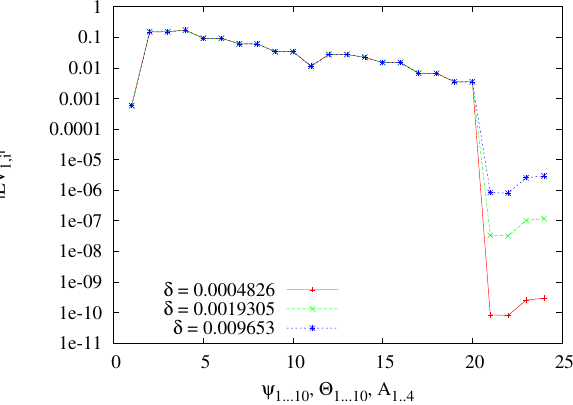
Fig. 7. Mean absolute amplitude of the first (backward) Lyapunov vector along the variables of the system, from 1 to 10, ψ i , from 11 to 20, θ i , and from 21 to 24, A i , as obtained after an integration of 10 6 days. The other parameters as in Fig.